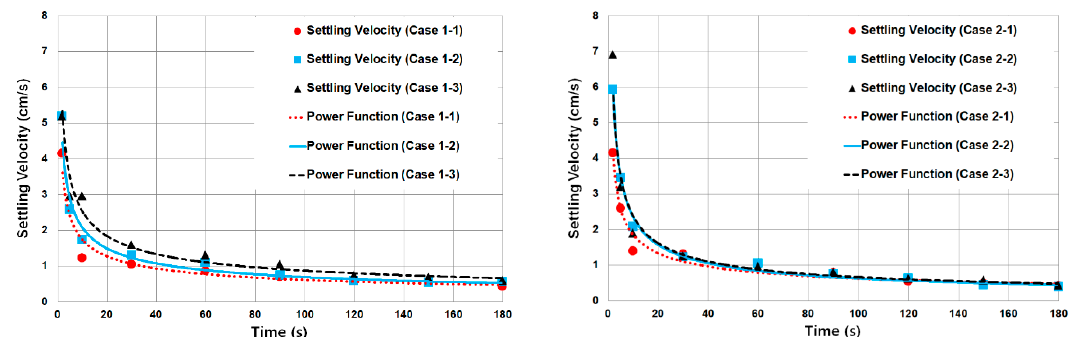
Figure 4. Comparison of observed data using a power function.